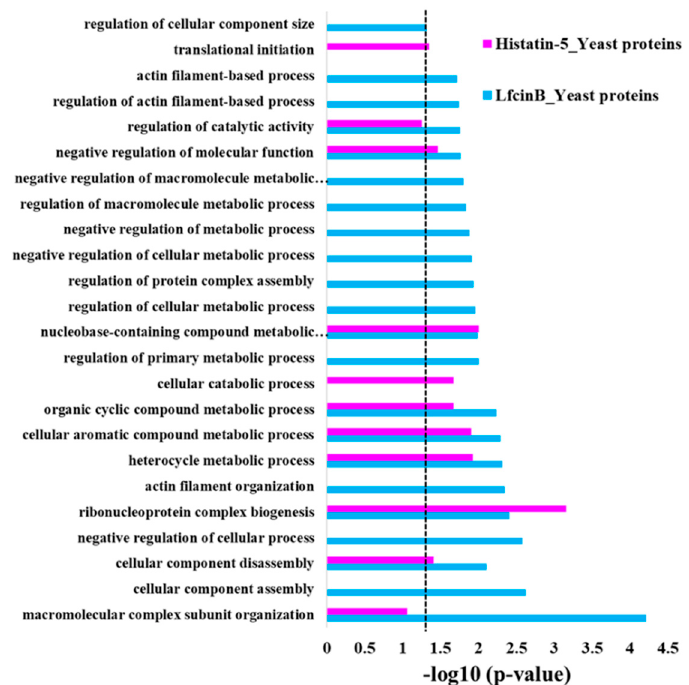
Figure 4. Enrichment in biological process of Lfcin B and Histatin-5 hits obtained from yeast proteome microarrays. The significant enrichment categories in biological process of Lfcin B and Histatin-5 of yeast-binding proteins (dotted line indicates the p -value of